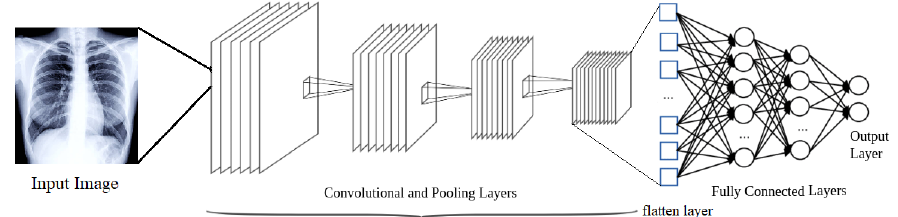
Figure 1. Architecture of Convolutional Neural